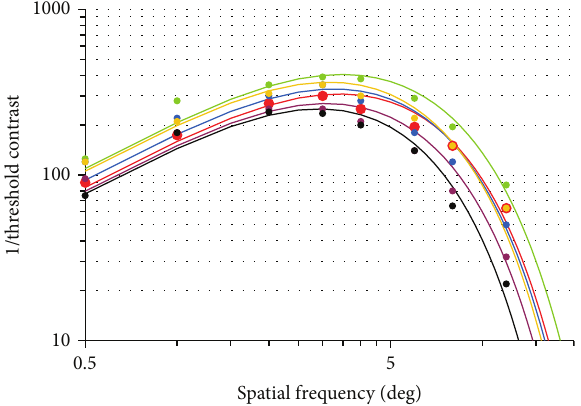
Figure5:ModelingofTulunay-Keeseyetal.’sdatawiththeproposed age-dependent CSF model (22). Green: 20 years; yellow: 40 years; blue: 60 years; red: 70 years; purple: 80 years; black: 90 years.